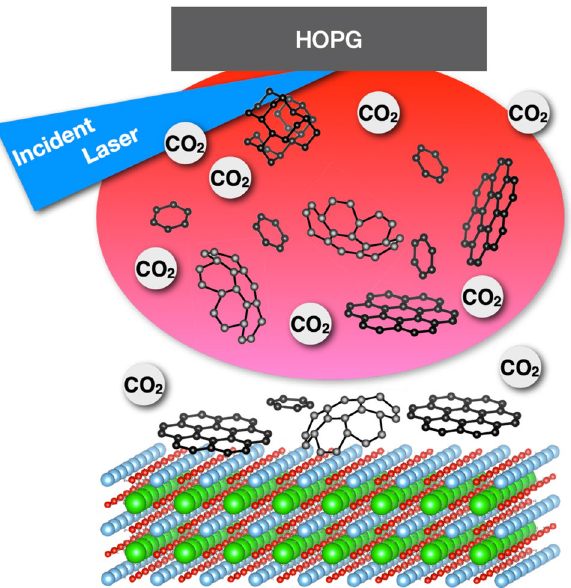
Figure 1. Designing of carbon clusters. With suitable atmospheric environment and choice of substrates, only graphitic carbon clusters can be designed to reach and flatly cover the surface of